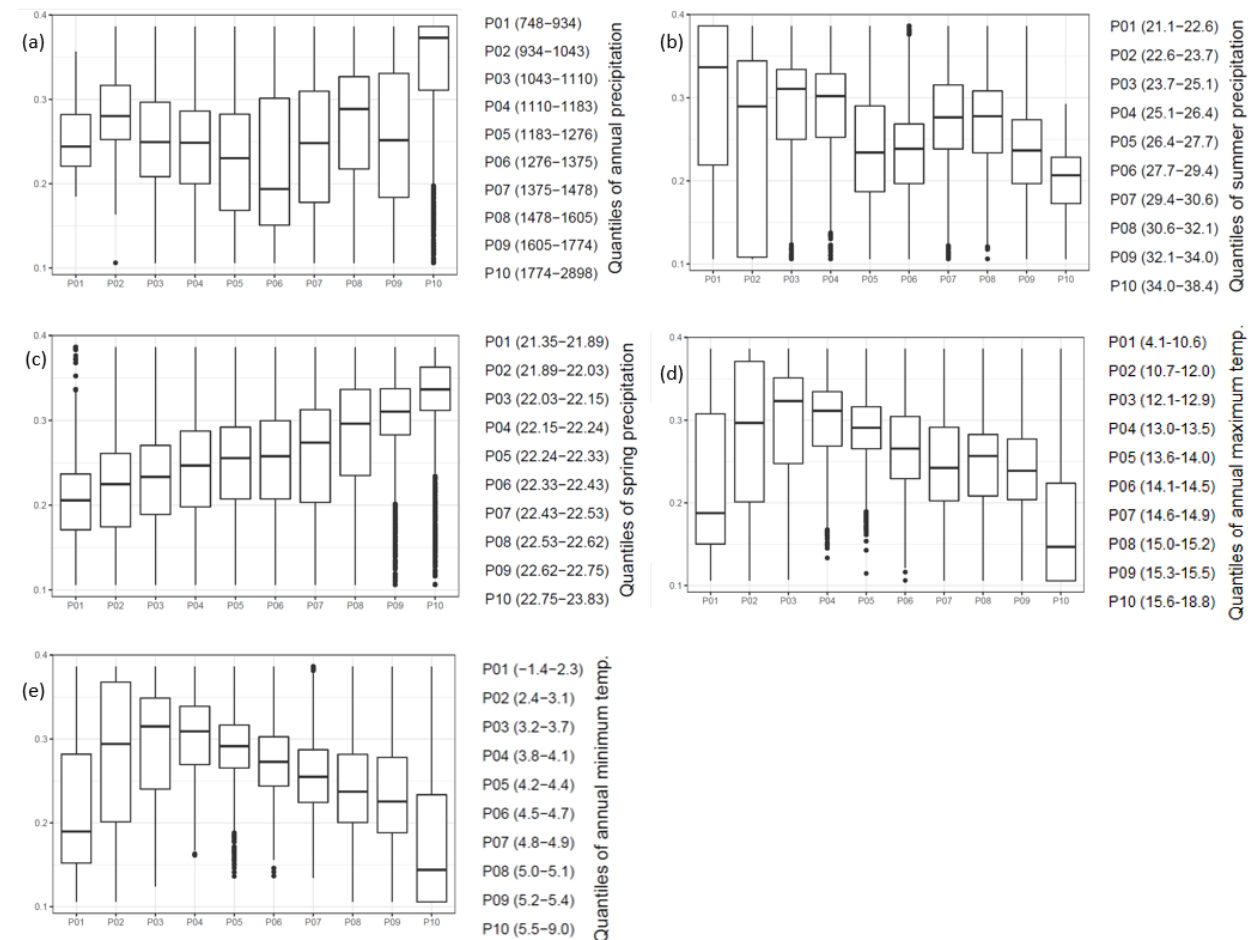
Figure 3. Potential percentage of beech in the growing stock ( y -axis) in different climatic percentiles ( x -axis) according to the main variables in the model. Each percentile contains equal number of forest stands with lowest (P01) and highest (P10) values in regard to ( a ) annual precipitation [mm], ( b ) summer precipitation [%], ( c ) spring precipitation [%], ( d ) annual maximum temperature [ ◦ C], and ( e ) annual minimum temperature [ ◦ C]. Upper and lower limits of boxes represent the 25th and 75th percentiles of data, while the inner horizontal bold line represents the median.